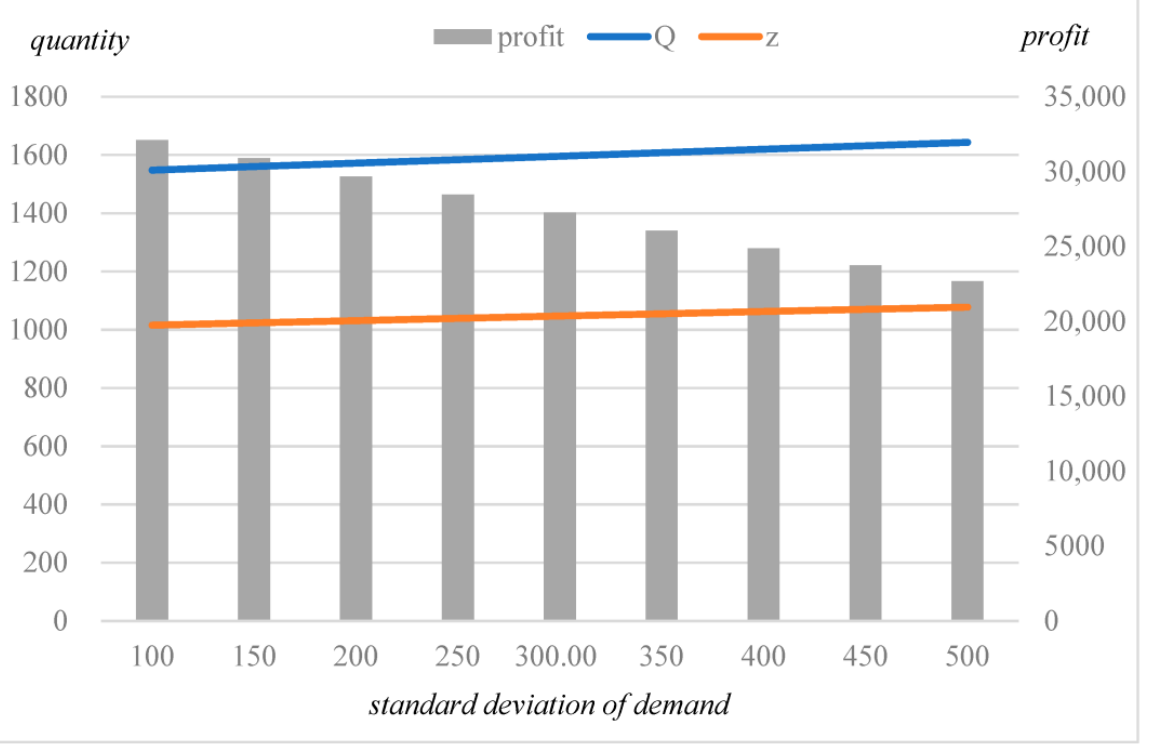
Figure 5. The results for various standard deviations of demand